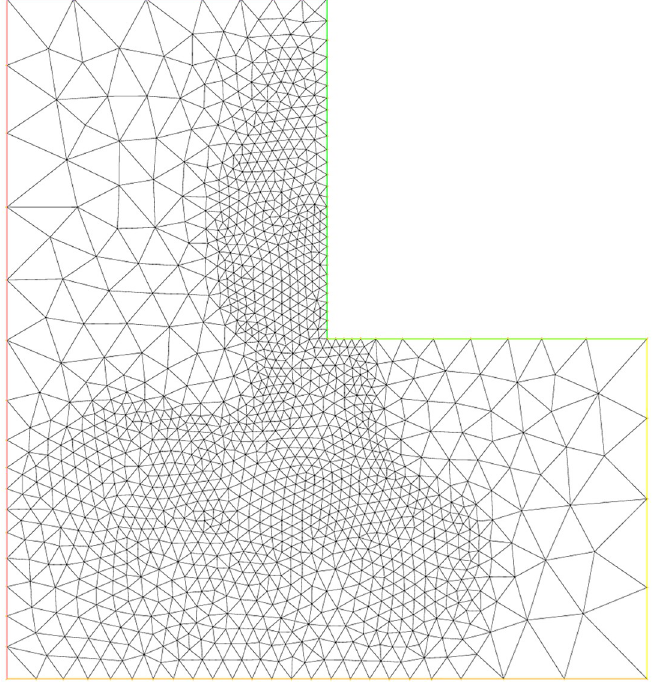
Fig 10. Adaptive mesh refinement with 4899 nodes for the L-shaped domain.